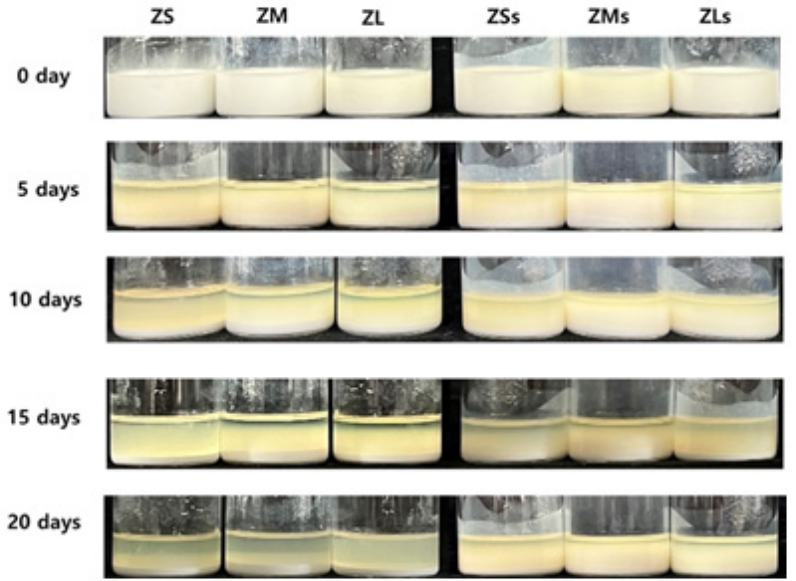
Figure 8. Sedimentation picture of suspensions with increasing days of before and after silane coat- ing.